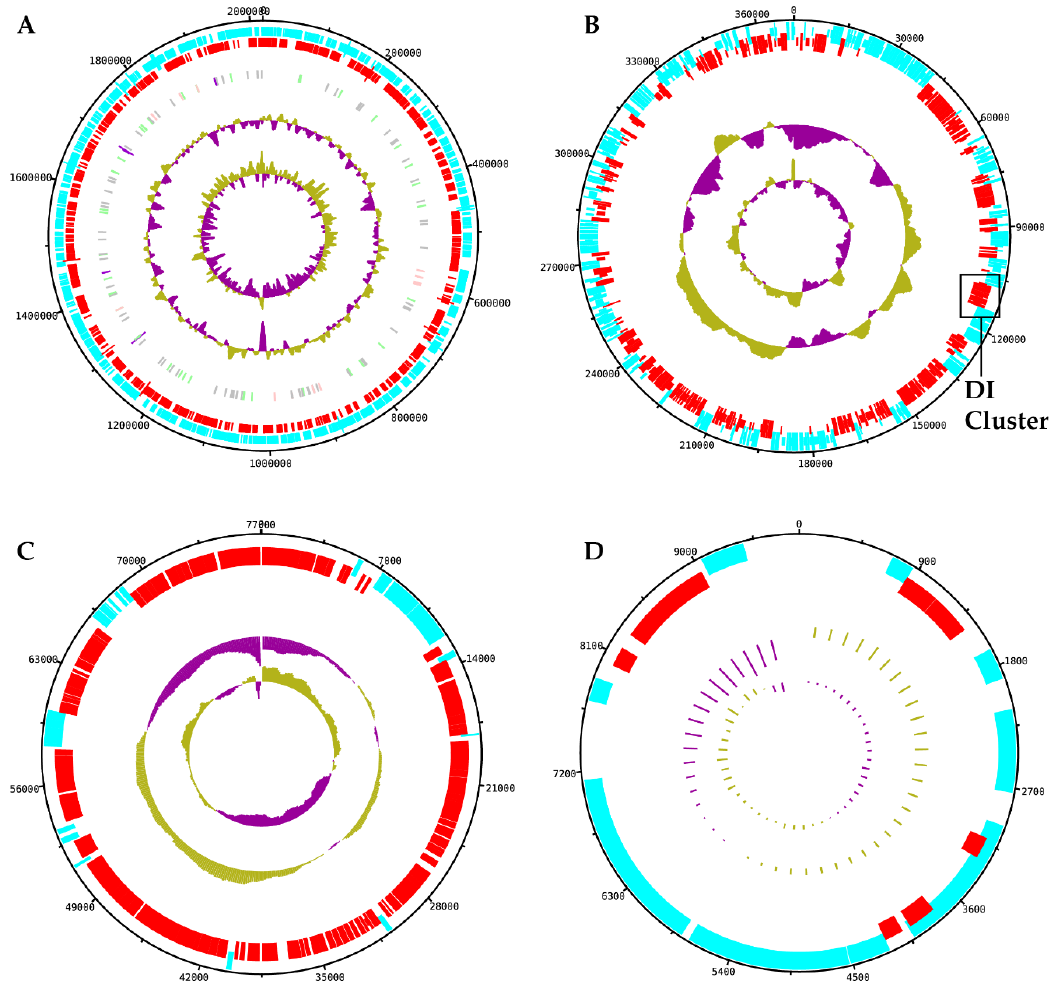
Figure 1. Genome of TthNAR1. Circular maps of the four replicons detected in TthNAR1 strain, elaborated using DNAPlotter using the consensus genome assembly achieved from supplementing PacBIO sequences with Illumina data. This strain harbors a highly conserved 2 Mbp chromosome ( A ) and plasmids of di ff erent sizes: a pTT27-like megaplasmid of 370 kbp ( B ) and two smaller plasmids of 77 kbp ( C ) and 9.8 kbp ( D ). These last two plasmids have little relation to other plasmids in the gene bank, as described in Figure S1. Localization of the nitrate and nitrite respiration cluster is indicated as DI cluster in the pTT27-like megaplasmid ( B